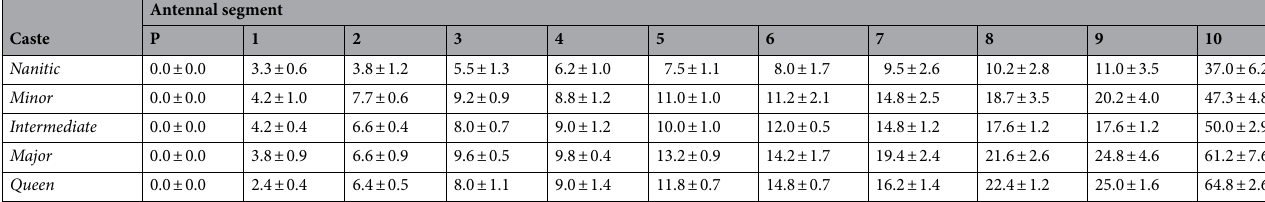
Table 1. Antennal distribution of basiconic sensilla across different C. pennsylvanicus castes. Sensillum counts represent the average and standard error of the dorsal and ventral total for each antennal segment ( n =